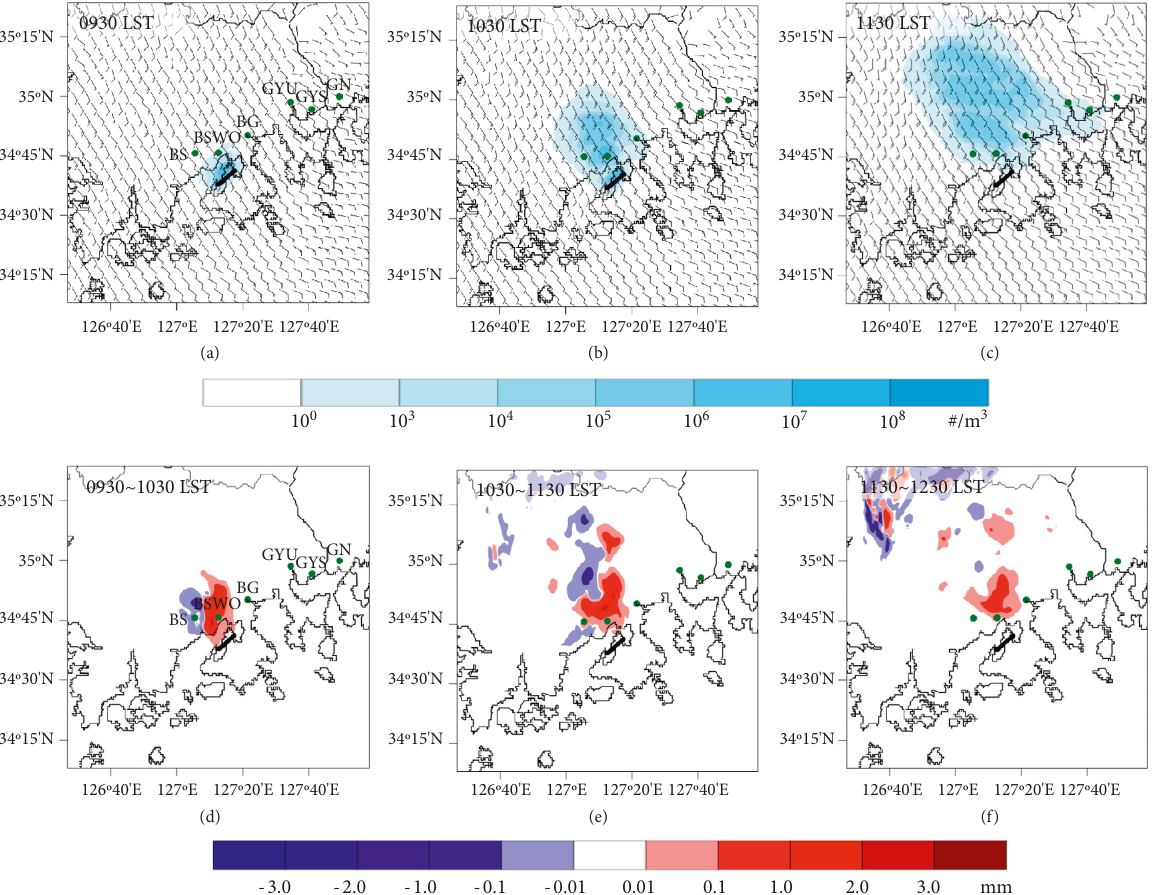
Figure 9: Horizontal distribution of seeding material dispersion (calcium chloride (CaCl precipitation difference at (d) 0930–1030, (e) 1030–1130, and (f) 1130–1230 LST on April 25, 2019, by numerical